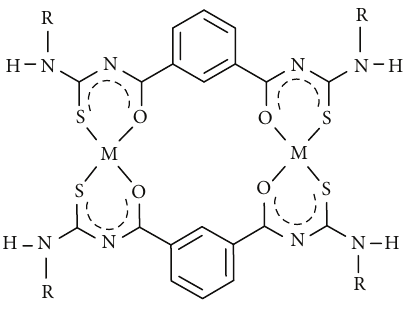
Figure 2: Proposed structure for metal(II) complexes (C 1 –C 10 ) where M = Cu(II) for (C 1 –C 5 ) and M = Ni(II) for (C 6 –C 10